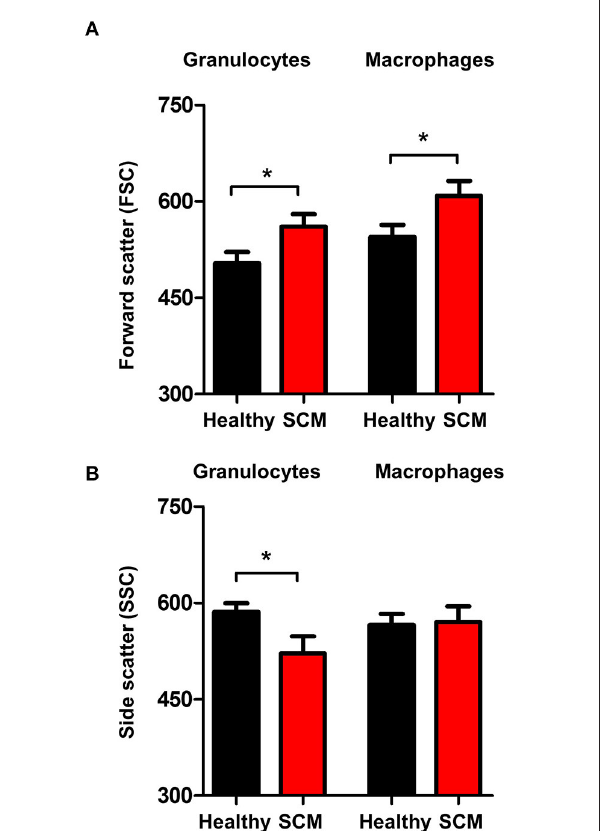
FIGURE 6 | Shape change in milk granulocytes. Milk granulocytes and macrophages were identified based on their staining with CD172a and CD14 antibodies in flow cytometry. Mean FSC (A) and SSC (B) were calculated and presented for healthy and SCM animals. *indicates significant differences between the means with p -values <